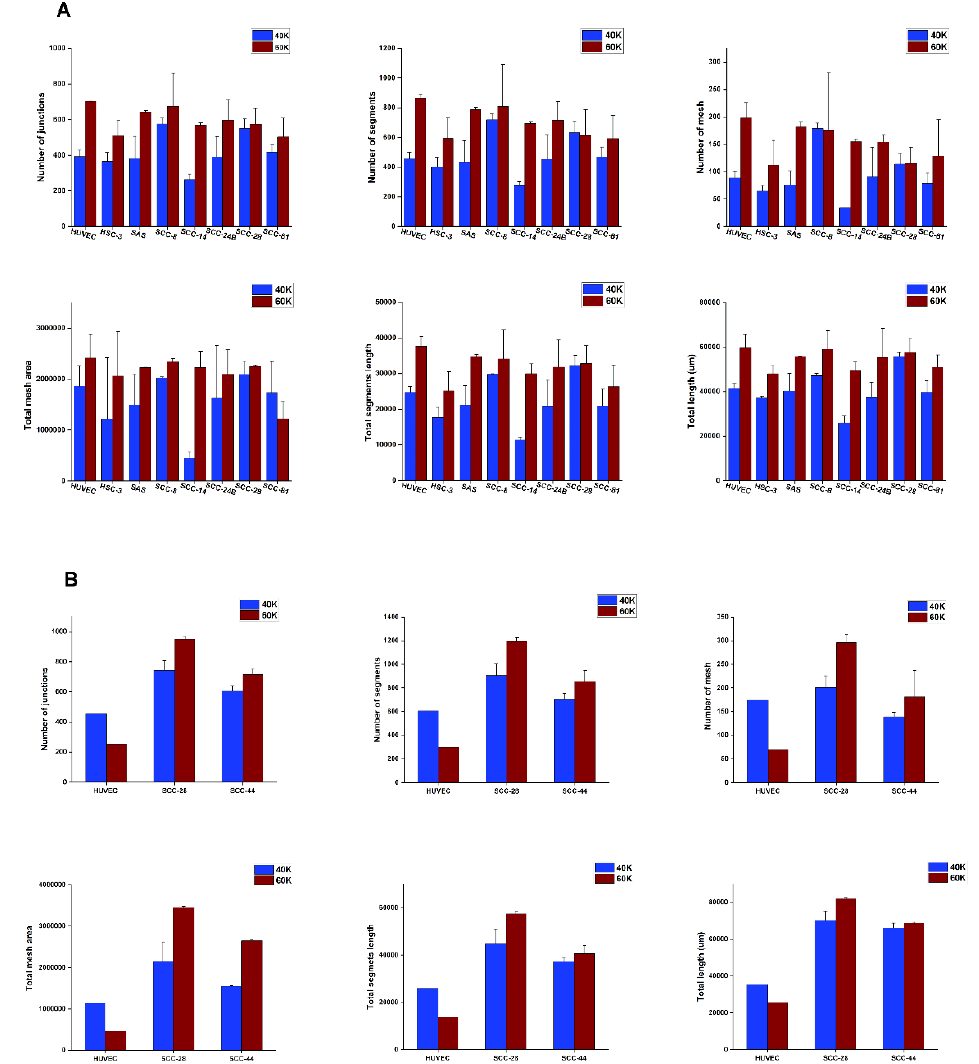
Figure 3. In vitro tube formation analysis of tumour cell-derived vascular mimicry (VM). ( A ) The Angiogenesis Analyser plugin was used to discern the optimal starting cell density needed to establish VM meshwork in vitro. Different tube formation parameters were analysed, including the number of junctions, segments, meshes, total mesh area, total segment length, and total branching lengths of the tubular networks. A starting cell density of 60 × 10 3 produced consistent mature loop- ing patterns in Matrigel for almost all the included cell lines. However, overall, the analysis shows that both 40 and 60 × 10 3 concentrations are sufficient to initiate VM structures in vitro. ( B ) The results were comparable in Myogel, with better tubes formed with a starting cell density of 60 × 10 3 . However, at such a higher density, HUVEC meshwork became more extensively interlaced in My- ogel, which limited the analyser’s capacity to recognize smaller tubular areas as shown in the figure. Data from one representative experiment, presented as mean ± SD of three technical replicates, are shown.